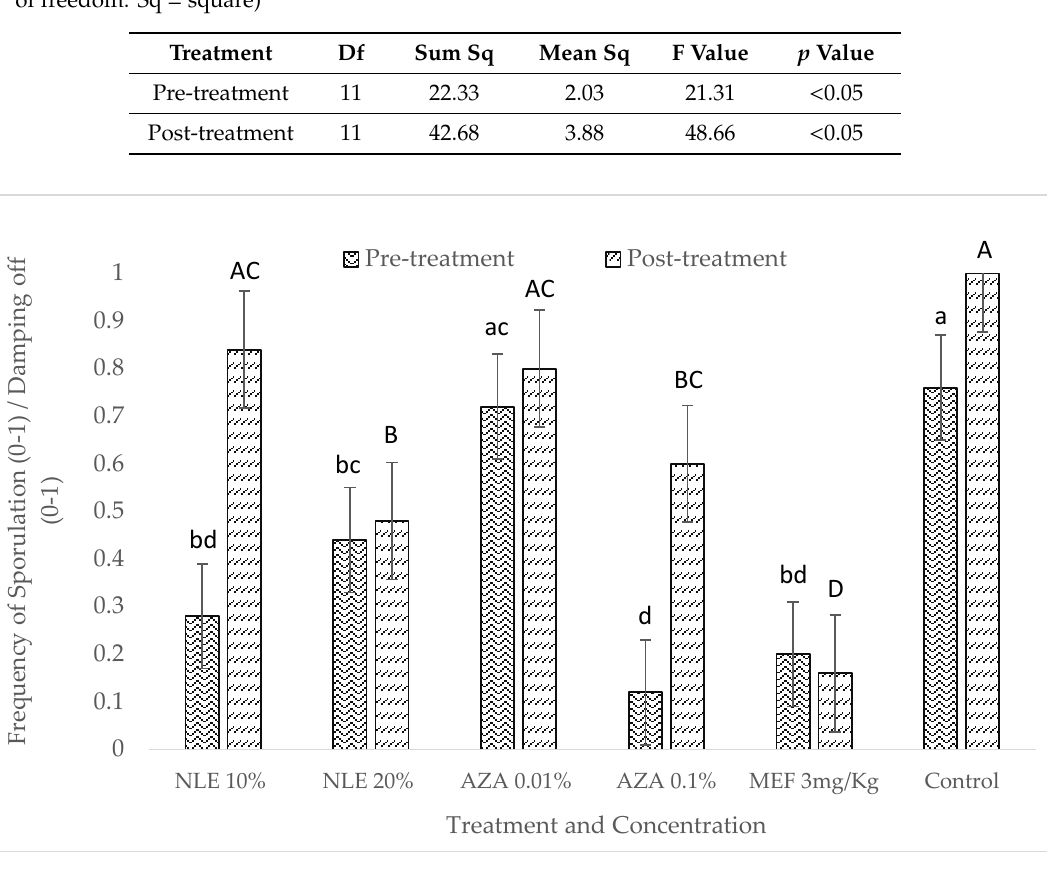
under in vivo conditions with p value, significantly di ff erent at 95% confidence interval. (Df = Degrees of freedom. Sq = square)